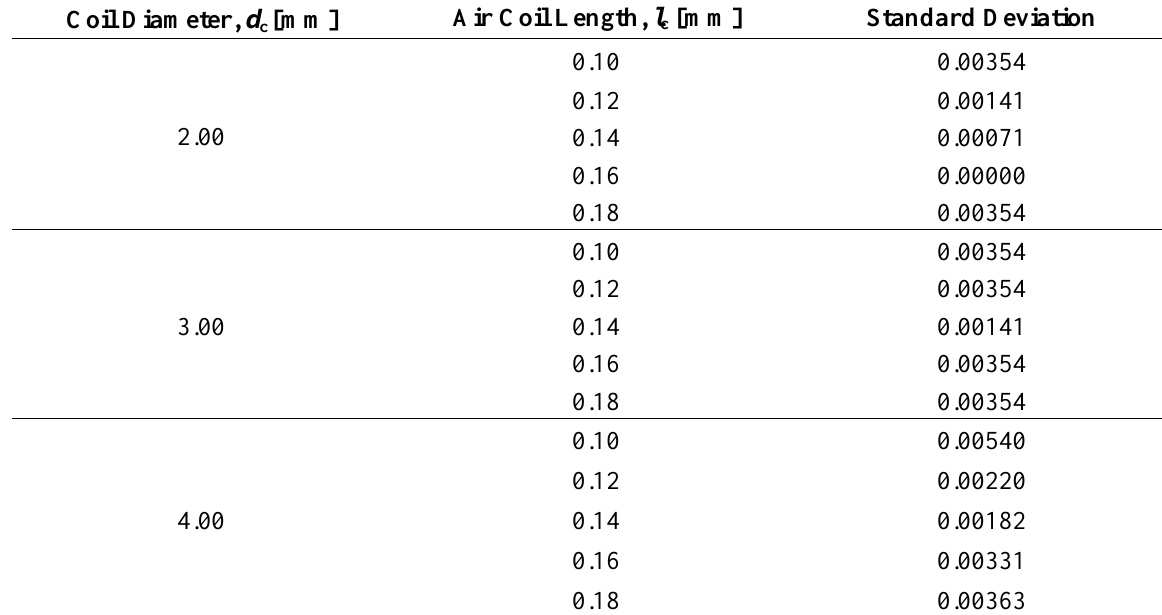
Table 7. The standard deviation value for all types of sensors calculated using ANOVA. Coil Diameter, d c